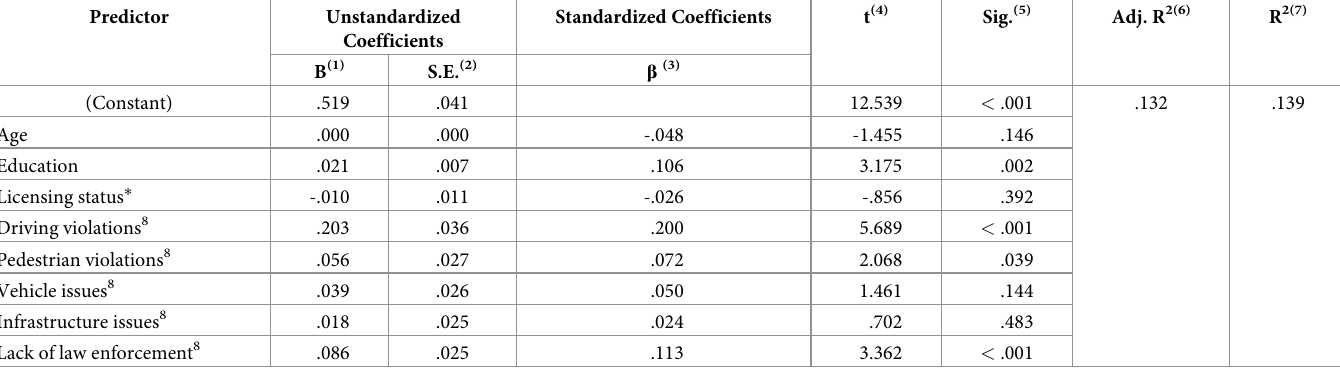
vance they attribute to traffic crashes, a multiple linear regression model was built. After controlling for age, educational level, and licensing status (dummy variable), a signifi- = 17.256, p < .001, and adjusted R 2 = .132. cant regression equation was found, with F (8,1251) The model’s constant was .519 + .106 (education) + .200 (driving violations) + .072 (pedestrian violations) + .113 (lack of law enforcement). Namely, the model outcomes suggest that greater values on the relevance given to driving violations, pedestrian violations, and lack of law enforcement were the three significant predic- tors of attributing greater importance to traffic crashes occurring in the country. Among demographic factors, the only significant predictor was education, which also had a positive effect on the dependent variable. The full set of significant and non-significant variables included in the model, their coefficients and cut-off values are shown in Table 4. Table 4. Linear regression model. Dependent variable: Importance attributed to traffic crashes in the Dominican Republic. Predictor Unstandardized